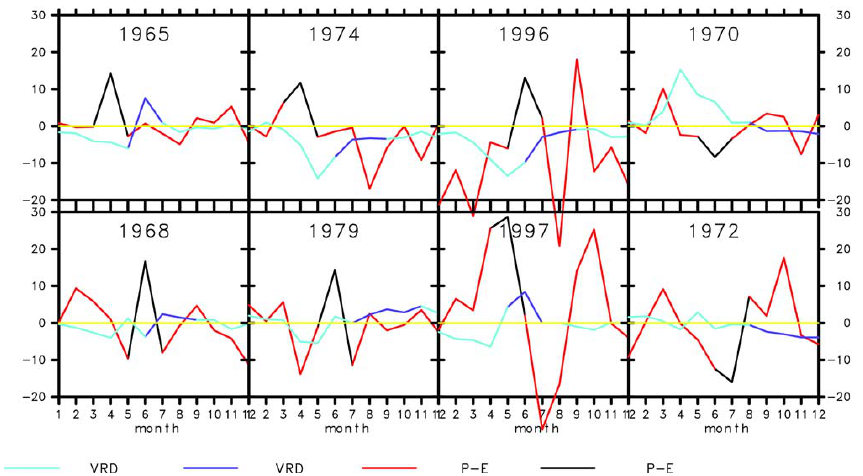
Fig. 3. Selection of years showing extreme events with P - E which are followed by extreme events in the VRD. The events are marked by different colours. The two right ones are those with deficient P - E .